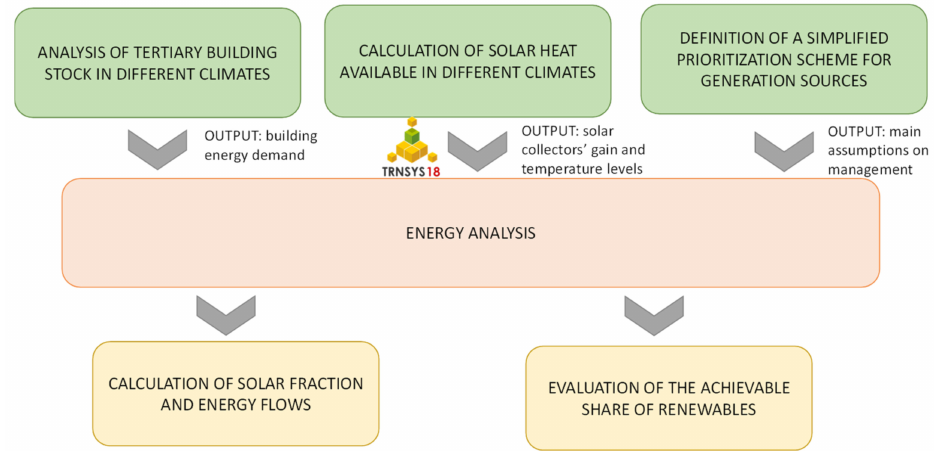
Figure 2. Methodology for the evaluation of the potentiality of the multi-generation system flow